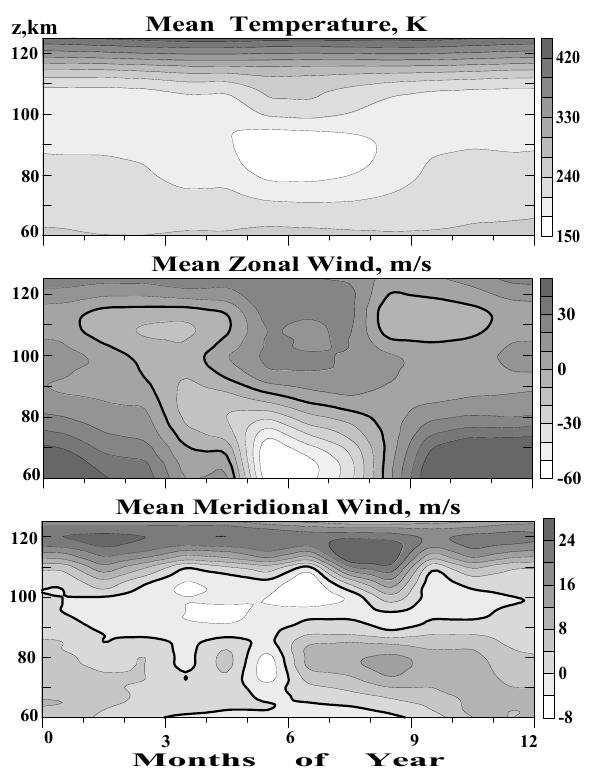
Fig. 2. The background temperature and wind components for the locations of the Collm Fig. 2. “Gavrilov and Jacobi, A study of seasonal…”